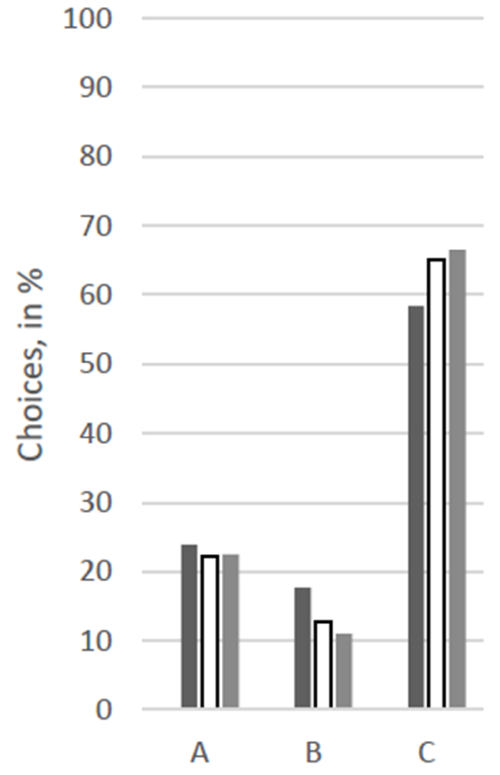
Figure 4. Answers for the scenario “2-year-old dog” in %. No participant opted for “D” in this scenario. Legend: black: human medicine group; white: control group; grey: veterinary medicine group; A: Euthanasia tablet, B: Sedation tablet, C: Potentially curative tablet, D: No treatment.